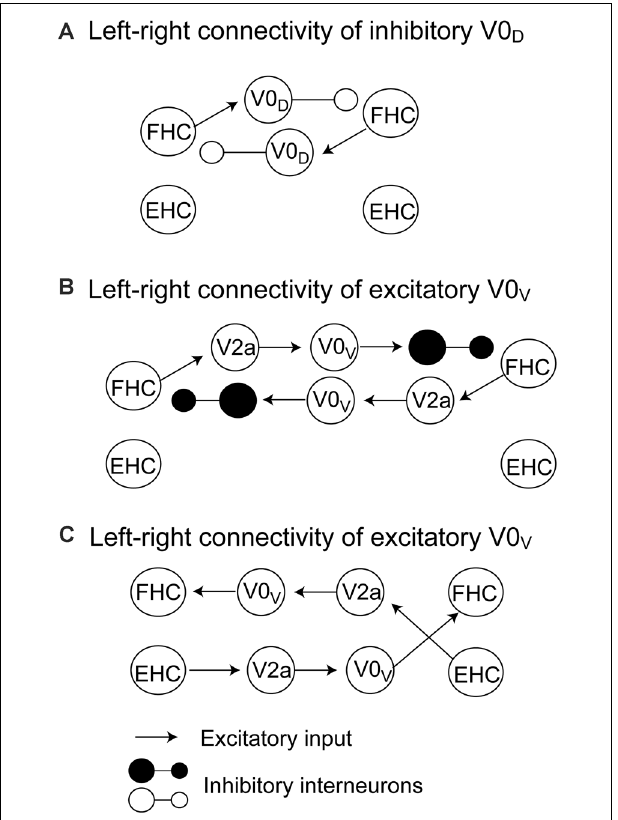
FIGURE 1 | The pathways mediating crossed inhibition between the left and right half centers proposed by Rybak et al. (2015) and Danner et al. (2017). The crossed inhibitory pathway involving V0 D commissural interneurons is shown in panel (A) . The crossed inhibitory pathways involving V0 V commissural interneurons are shown in panels (B) and (C) . The detailed explanation is presented in the text. FHC, flexor half center; EHC, extensor half